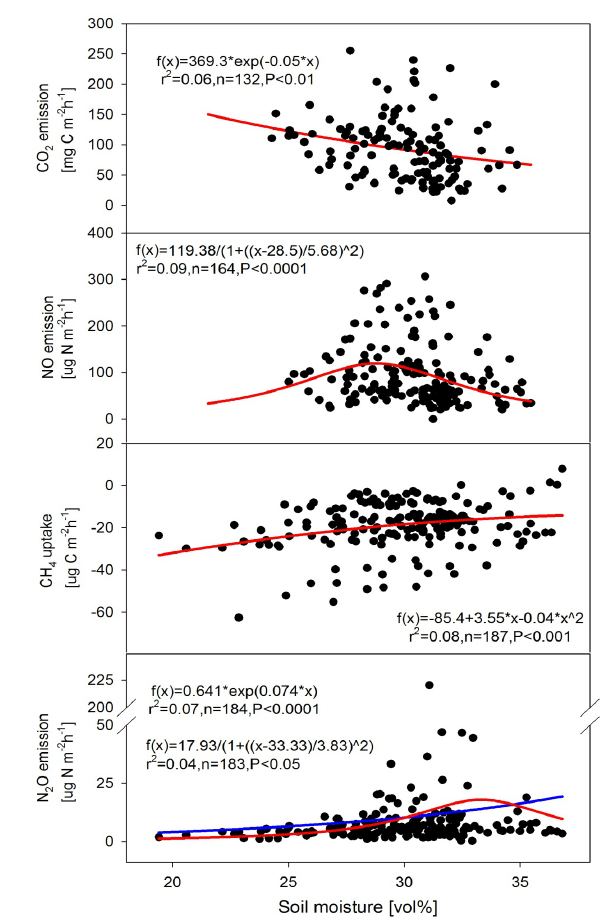
Fig. 6. Dependencies of soil trace gas emissions on soil moisture (at 10cm soil depth). For this analysis monthly mean values as ob- tained for the period 1994–2010 were used. N 2 O: freeze-thaw peri- Figure 6. Dependencies of soil trace gas emissions on soil moisture (at 10 cm soil depth). For 3 ods this analysis monthly mean values as obtained for the period 1994-2010 were used. 4